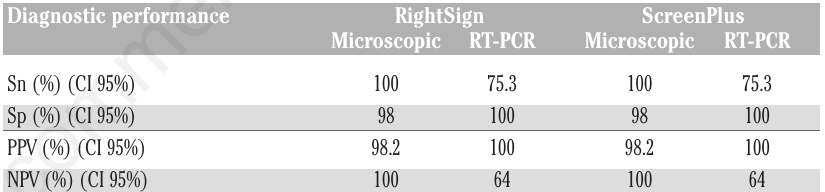
Table 2 Diagnostic performance of RightSign and ScreenPlus compared to microscopic and real-time PCR Examination.